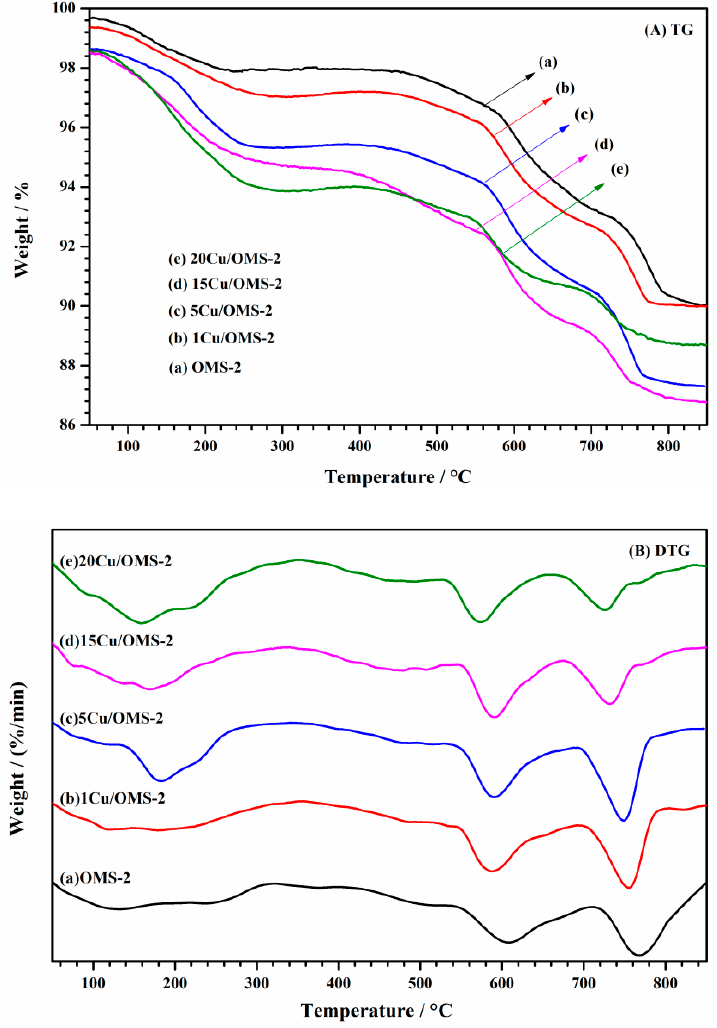
Figure 4. ( A ) TG and ( B ) DTG plots of ( a ) OMS-2, ( b ) 1Cu/OMS-2, ( c ) 5Cu/OMS-2, ( d ) 15Cu/OMS-2, and ( e ) 20Cu/OMS-2. Table 1. Thermal analysis results of the OMS-2 and x Cu/OMS-2 samples at different temperatures.